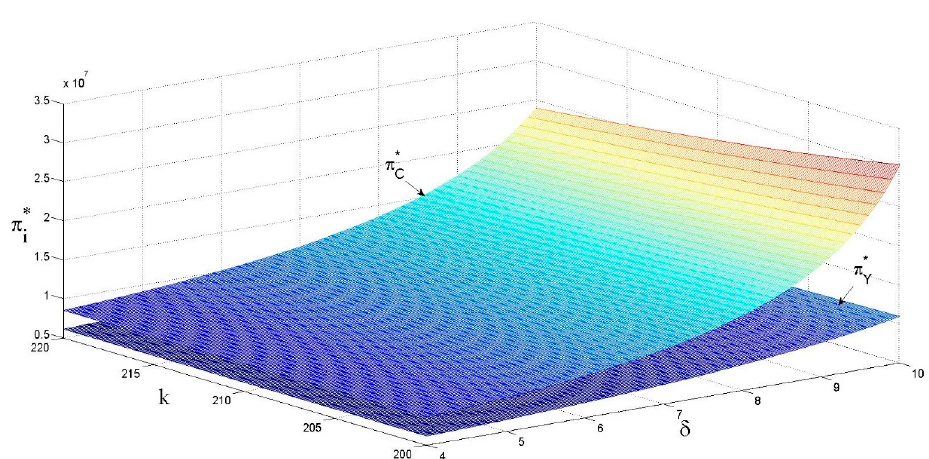
δ on the revenue in centralized decision-making . Figure 8. The effects of k and